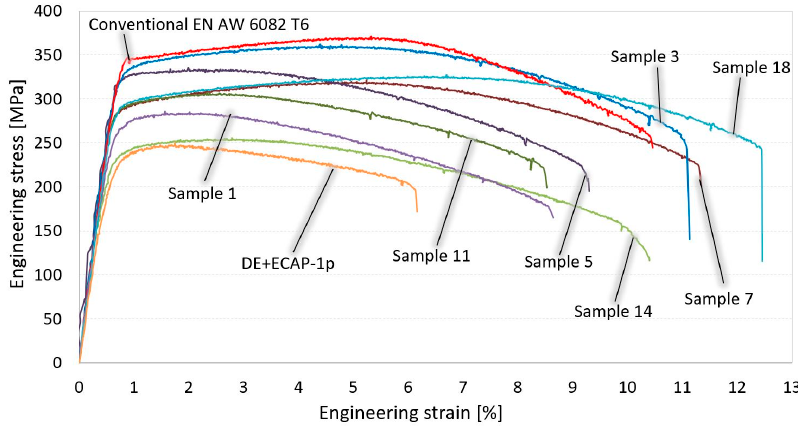
Figure 4. Engineering stress vs. engineering strain diagrams for: one SSR sample obtained with DE and afterwards one ECAP pass; seven randomly selected SSR samples from design of experiments (DOE); conventionally extruded bar in T6 condition.